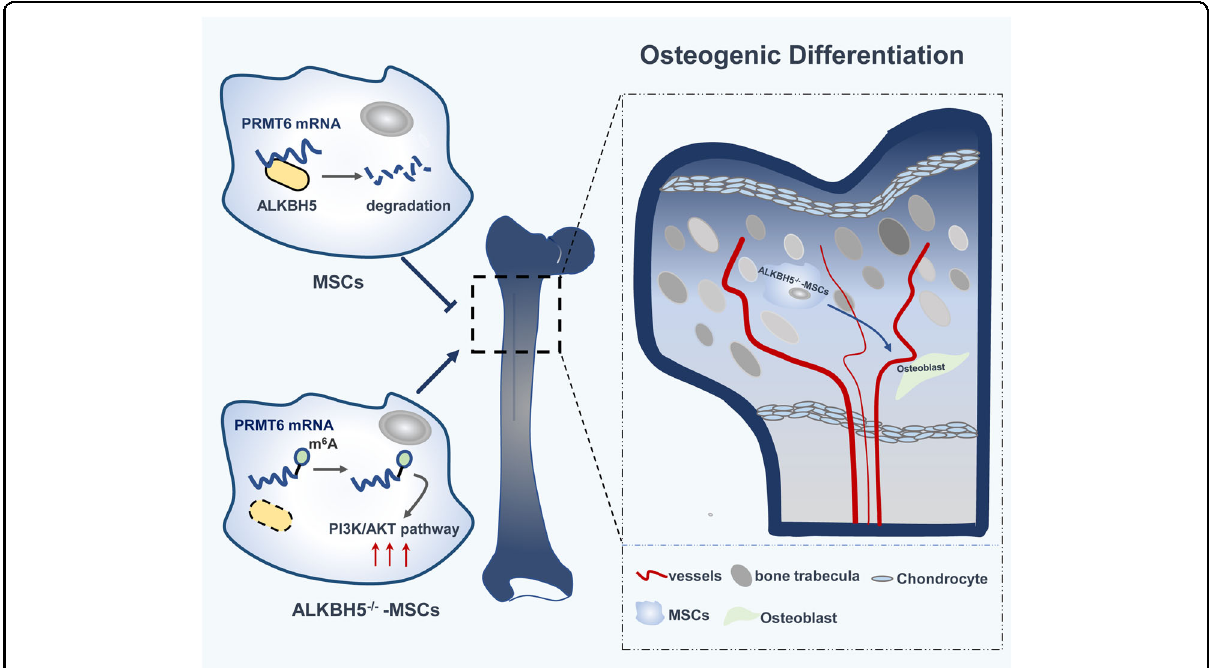
Fig. 8 Working model depicting how ALKBH5 regulates the osteogenic differentiation of MSCs. ALKBH5 negatively regulates the osteogenic differentiation of MSCs by increasing the mRNA decay rate of PRMT6 , so as to inhibit the activation of PI3K/AKT pathway in bone